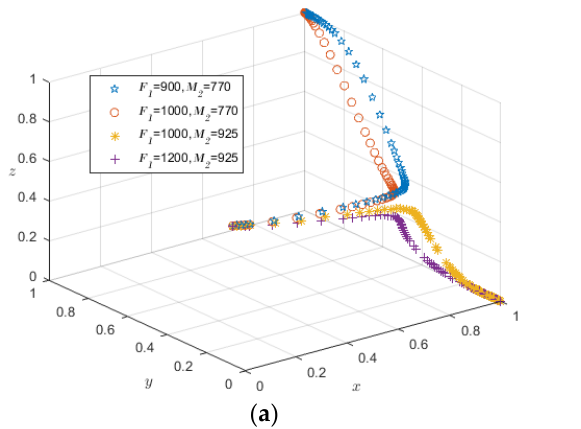
Figure 9. Evolution path of F 1 and M 2 under different values: ( a ) System A with (x 0 , y 0 , z 0 ) = (0.32,